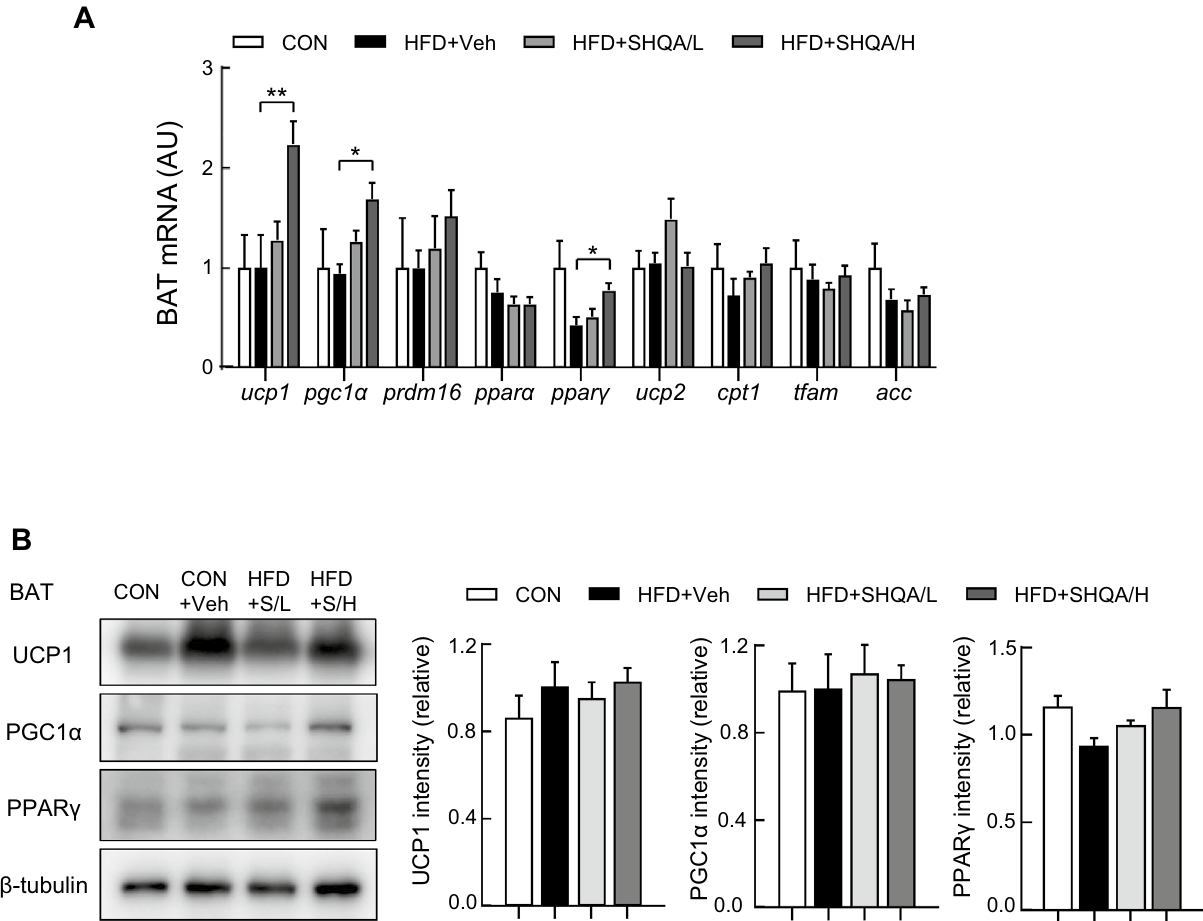
Figure 5. SHQA injection alters gene expression signature in brown adipose tissues of mice. C57BL/6 mice (4 weeks old) were fed a chow diet (CON) or a HFD with the hypothalamic injection of PBS (CON or HFD + Veh, three times a week), a low dose (HFD + SHQA/L or HFD + S/L, 20 ng/µl, three times a week) or a high dose of SHQA (HFD + SHQA/H or HFD + S/H, 100 ng/µl, three times a week) for 12 weeks. The brown adipose tissues from these mice were collected for measuring mRNA and protein levels. ( A ) mRNA expression levels of genes related to adipose tissue browning and thermogenesis were measured in brown adipose tissues (n = 6-7). ( B ) The protein levels of UCP1, PGC1α, and PPARγ in BAT were measured by western blots (n = 4-5) with only representative bands shown in the figure (whole images of blot were shown in Supplementary Fig. S1). Data are expressed as mean ± S.E.M. Statistical differences between CON, HFD + Veh, HFD + SHQA/L (SHQA, 20 ng/µl), and HFD + SHQA/H (SHQA, 100 ng/µl) were determined using one-way ANOVA followed by the Tukey’s post hoc test ( A and B ): * p < 0.05, ** p < 0.01 compared to